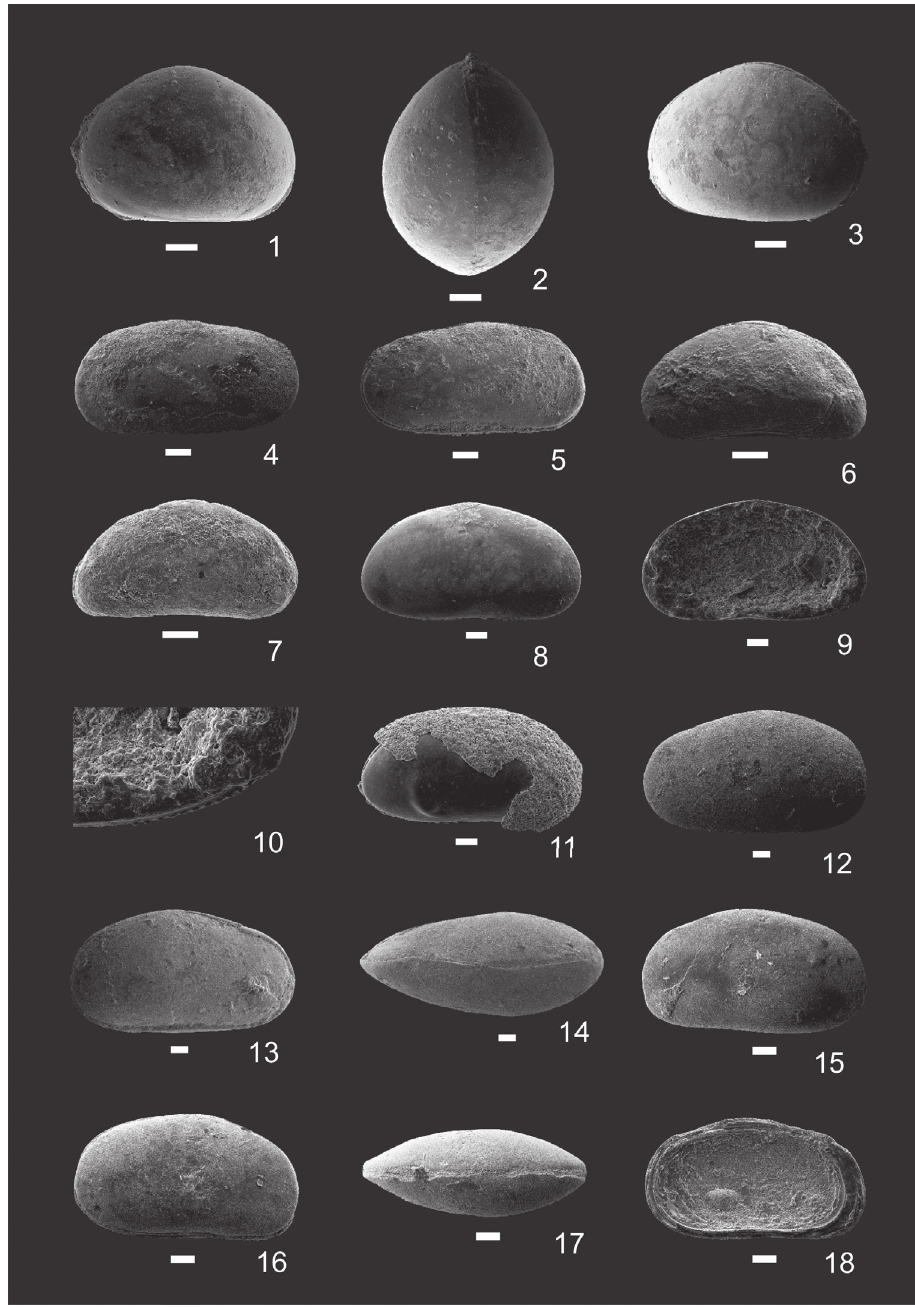
Figure 3 - 1-3 Cypretta sp. (ULVG 11506, C) 1. Left lateral view; 2. Dorsal view; 3. Right lateral view; 4-5 Strandesia sp. (ULVG 11507, C) 4. Left lateral view; 5. Right lateral view; 6-7 Potamocypris sp. (ULVG 11508, C) 6. Left lateral view; 7. Right lateral view; 8-11 Heterocypris sp. 1 (ULVG 11509, RV and ULVG 11510, C) 8. RV external view; 9. RV internal view; 10. Detail of the posteroventral region of RV; 11. C with posteroventral nodule; 12-14 Heterocypris sp. 2 (ULVG 11511, C) 12. Left lateral view; 13. Right lateral view; 14. Dorsal view; 15-18 Heterocypris sp. 3 (ULVG 11512, C and ULVG 11513, LV), 15. C left lateral view; 16. C right lateral view; 17. C dorsal view; 18. Left valves cup-in-cup.